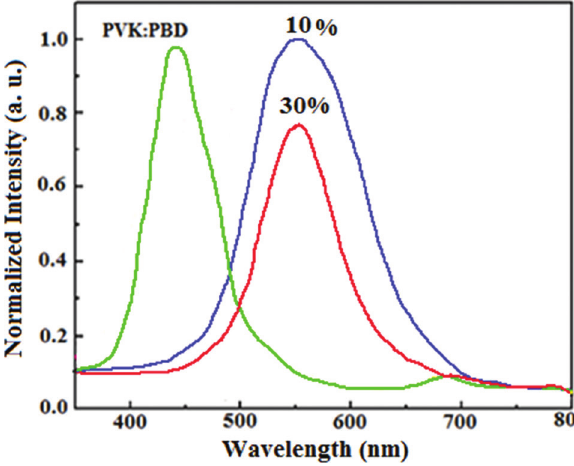
Figure 9: Electroluminescence spectra of prepared OLED devices.